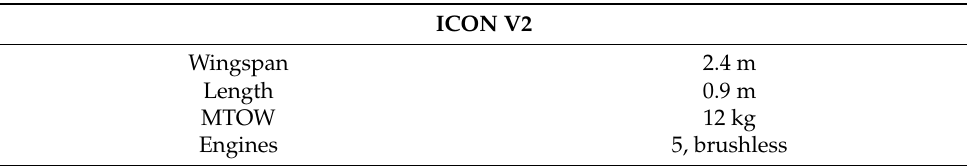
Figure 2. Multirotor ICON V2, PROS3. ( a ) Back view of the aircraft, not operative at ground, ( b ) front view of the UAV during take-off, the rear propeller is switched off during this phase. Table 1. Main features of ICON